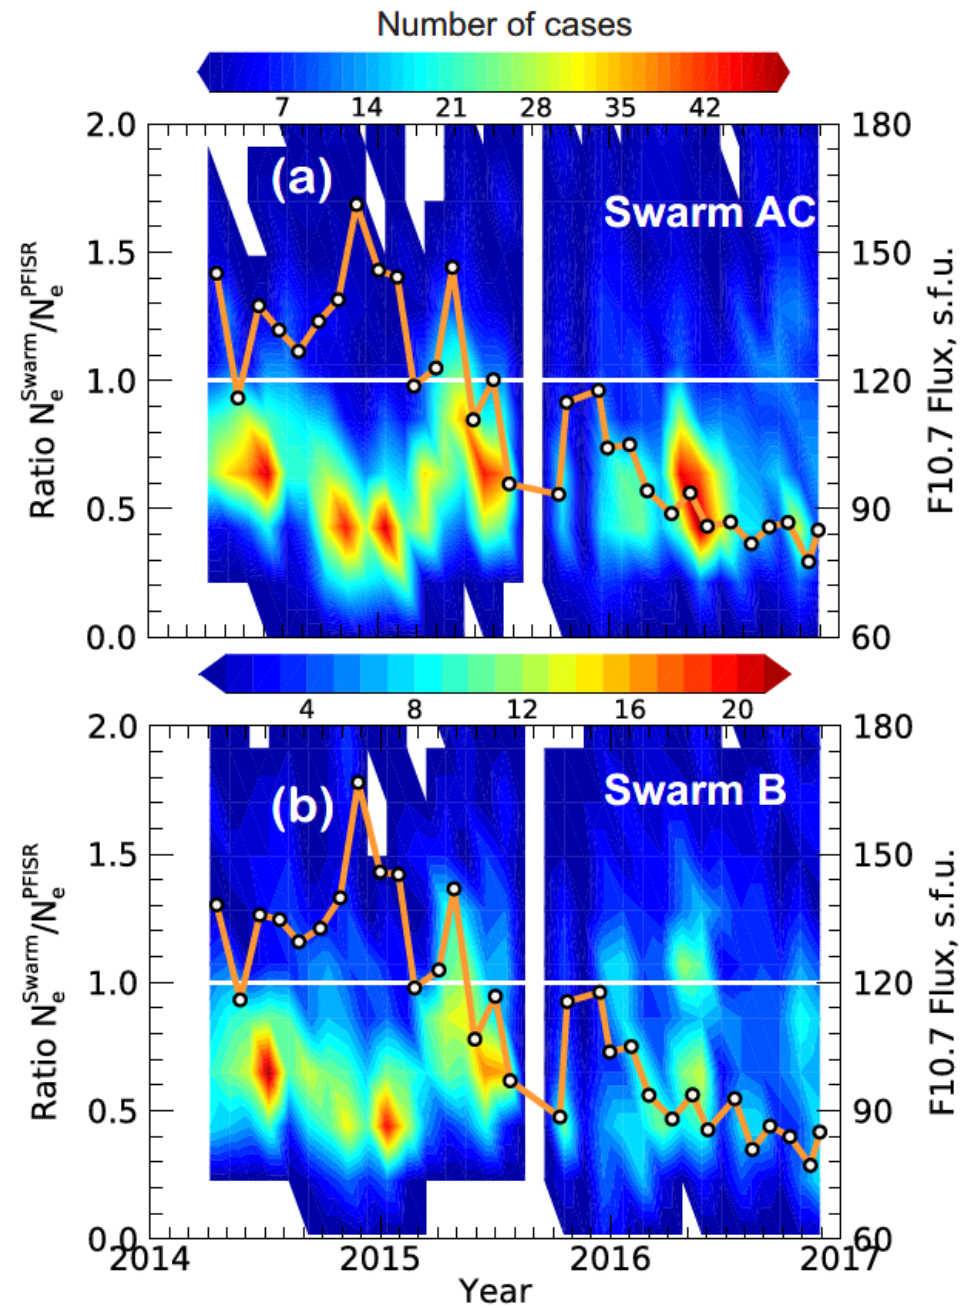
Figure 6. ( a ) A contour plot for the occurrence of the ratio R = N eSwarm /N ePFISR for Swarm AC versus year of the radar–satellite conjunctions. The ratio is scaled according to the bar at the top of each plot. Black circles are the F10.5 cm radio flux (given in s.f.u. units). The scale for the radio flux is given on the right. ( b ) The same as ( a ) but for the Swarm B satellite.